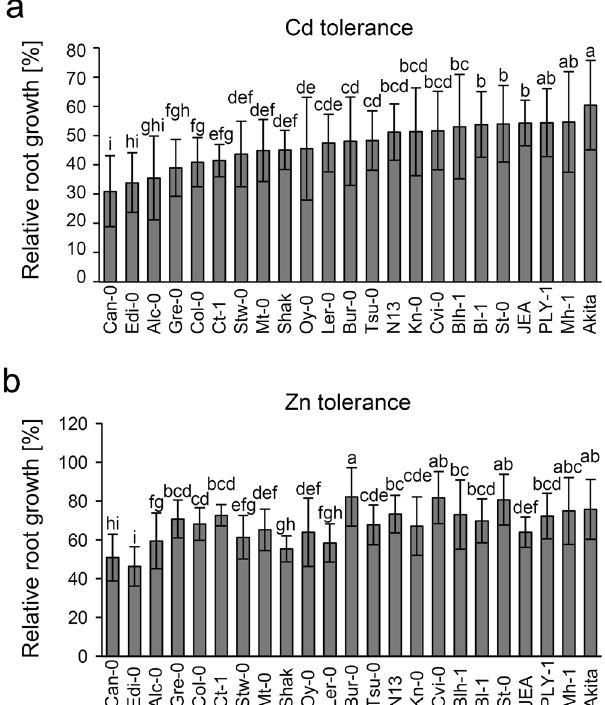
Figure 1. Natural variation in A. thaliana Zn and Cd tolerance. 23 accessions of the Versailles Core24 were grown on vertical agar plates under control conditions or in the presence of either 5 µ M CdCl 2 ( a ) or 50 µ M ZnSO 4 ( b ). Length of primary roots was determined after 12–14 d. Relative root growth of seedlings as an indicator for tolerance was calculated as follows: root length metal treatment/mean root length control conditions × 100. Absolute root lengths (in mm) under control conditions were: Bl-1: 64 ± 17; Stw-0:66 ± 26; N13: 69 ± 26; Akita: 70 ± 18; Shak: 77 ± 19; St-0: 82 ± 14; Blh-1: 83 ± 16; Ct-1: 84 ± 19; Kn-0: 85 ± 20; Can- 0: 85 ± 16; Mh-1: 87 ± 18; Col-0: 88 ± 15; Ply-1: 90 ± 22; Cvi-0: 90 ± 14; Oy-0: 91 ± 23; Edi-0: 91 ± 16; JEA: 92 ± 22; Tsu-0: 94 ± 21; Ler-0: 94 ± 24; Mt-0: 96 ± 17; Bur-0: 99 ± 22; Gre-0: 102 ± 23; Alc-0: 103 ± 20). Data represent means ± SD. Per accession 17 to 185 plants were compared. The average n was 119. Statistical analysis was performed via one-way ANOVA and data were grouped based on Tukey’s 95% confidence